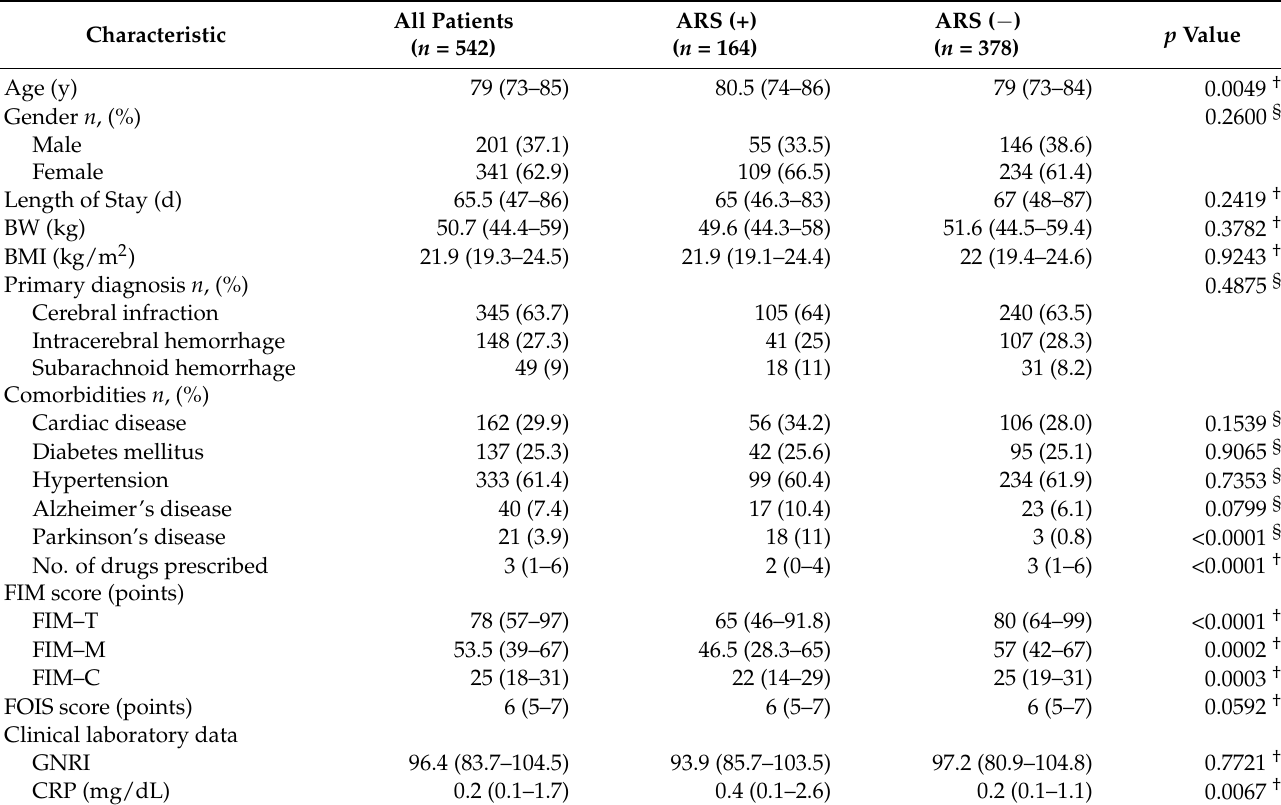
Figure 1. Flowchart of participant screening, inclusion criteria, and follow-up. Table 1. Baseline of demographic characteristics and laboratory data between ARS (+) group and ARS (–) group.